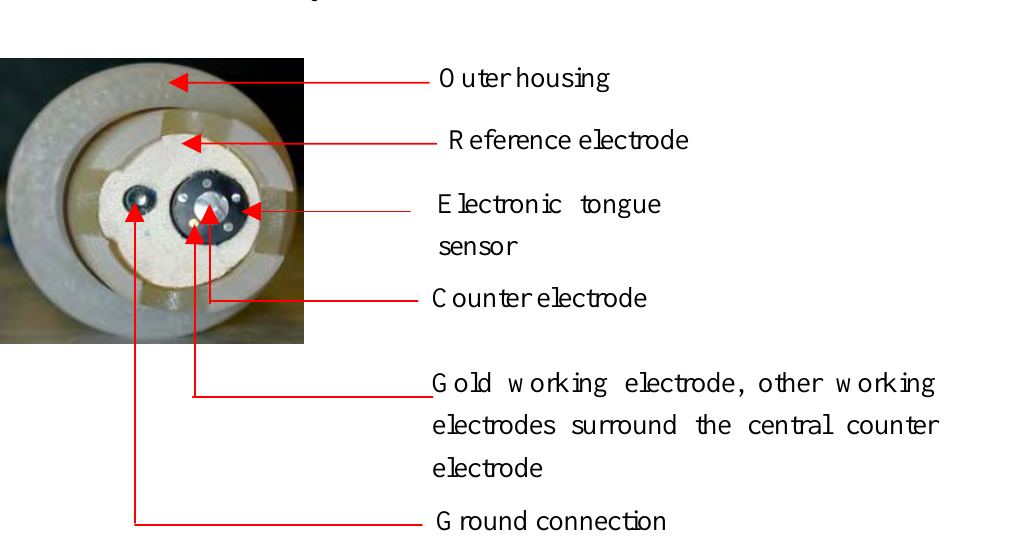
Figure 1a. A Voltammetric Electronic Tongue Sensor inserted in a Kynar housing with inbuilt reference electrode.